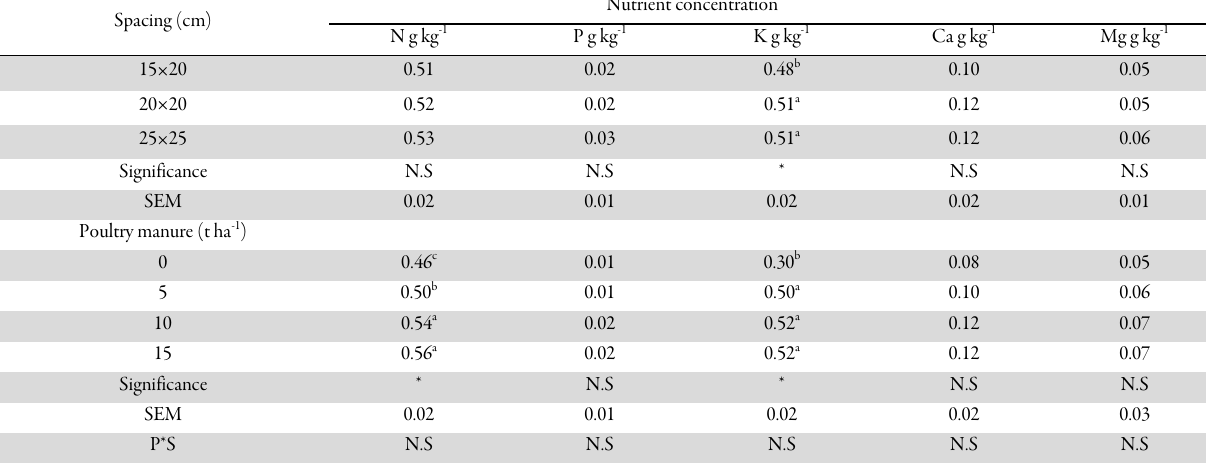
Table 4. Effect of poultry manure and spacing on nutrient concentration of onion leaves